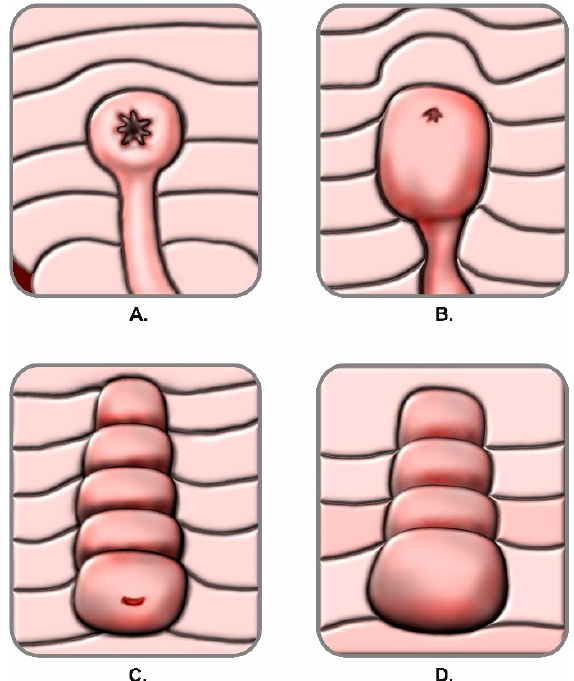
Figure 2. Anatomical variations of the papilla: ( A ) Type 1; ( B ) Type II; ( C ) Type III; ( D ) Type IV. Adapted after Canard et al., 2011 [17].